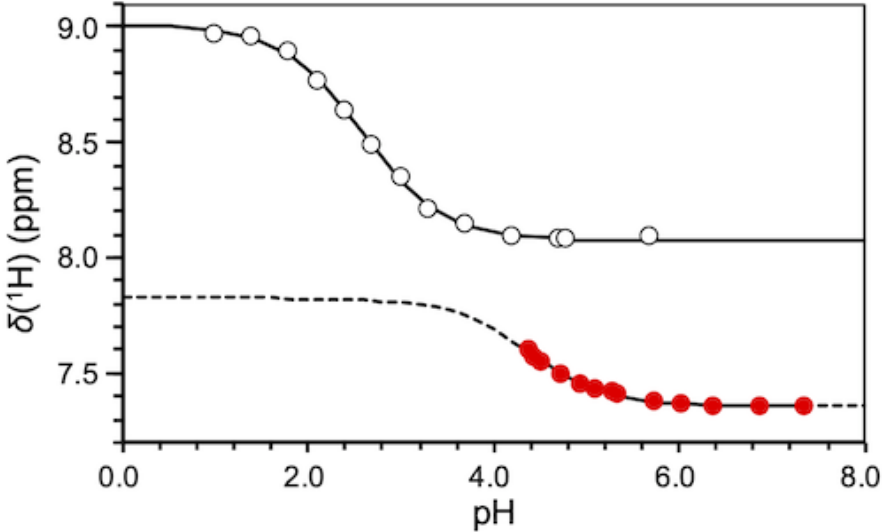
Figure 7. Plot of the chemical shift of H8(G10.1*) of the model RNA duplex 1 against pH (acidic region) in the absence of CdCl 2 . Red circle: H8(G10.1*) chemical shift. Open circle: H8(5 (cid:48) -GMP) chemical shift. In the respective titration data, their corresponding theoretical curves are indicated. In the theoretical curves for model RNA duplex 1 , extrapolated theoretical curves are presented as broken